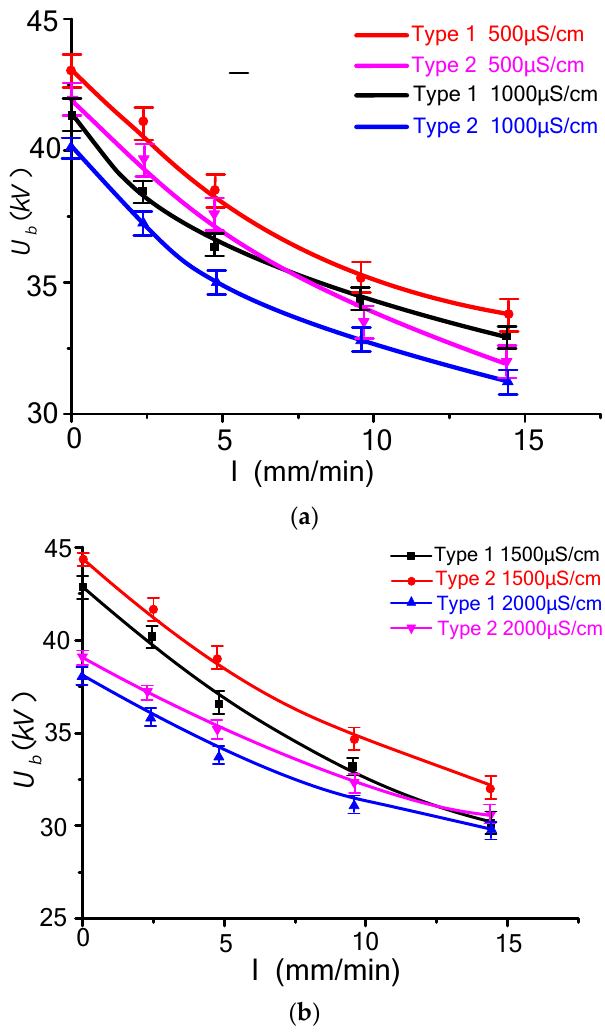
Figure 4. Effects of rain intensity on flashover voltage: ( a ) I = 500, 1000 μS/min ( b ) I = 1500, 2000 μS/min.